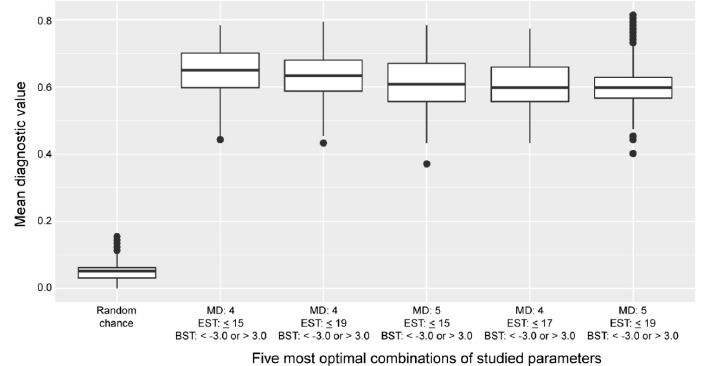
Figure 4. Distribution of the diagnostic values of the five most favorable parameter combinations of the cross-omics method compared to the diagnostic value if based on random chance. Boxplots indicate the distribution of the diagnostic values over 1000 cross-omics analyses. Abbreviations: BST, biochemical stringency threshold; EST, extension stringency threshold; MD, maximum distance to the primary reaction.